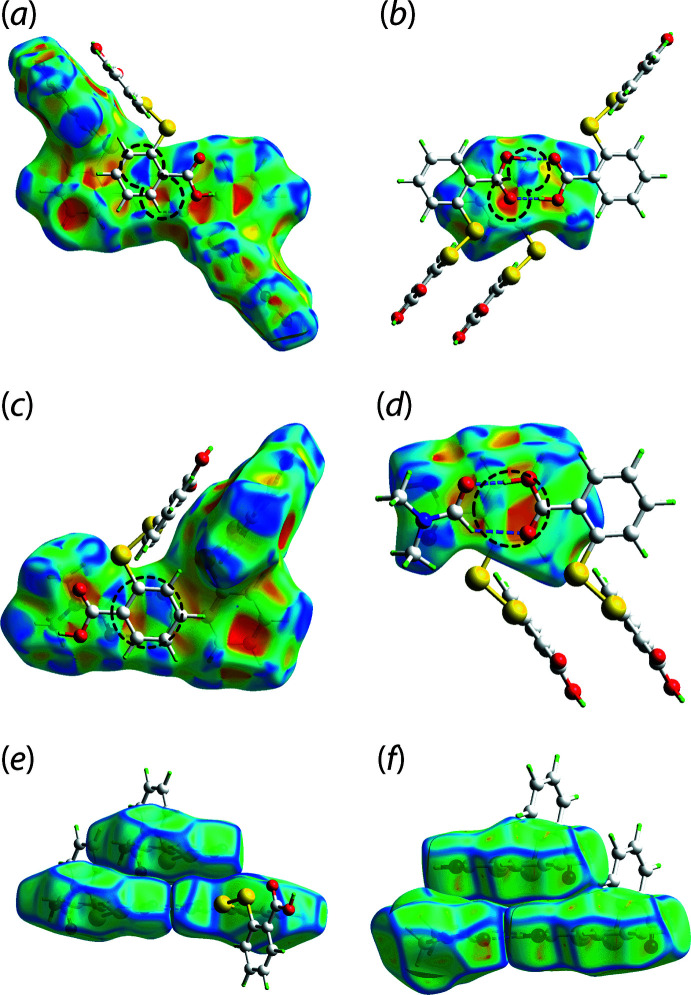
The Hirshfeld surface mapped with shape index (property range: −1.0 to +1.0 arbitrary units) for (a) a DTBA dimer, (b) a benzoic acid fragment in the opposite view of the DTBA dimer shown in (a), (c) a DTBA⋯DMF dimer and (d) a benzoic acid fragment in the opposite view of the DTBA⋯DMF dimer shown in (c). The Hirshfeld surface mapped with curvedness (property range: −4.0 to +0.4 arbitrary units) for the (e) π(C8–C13)⋯quasi-(⋯O4–C14–O3–H3O)2 inter­action and (f) π(C2–C7)⋯quasi-(O2–C1–O1–H1O⋯O5–C15–H15) inter­action. Both shape index and curvedness studies reveal the shape complementarity (as circled for the concave and convex represented by the red and blue regions in shape index) for the stacking arrangements between the corresponding ring systems.